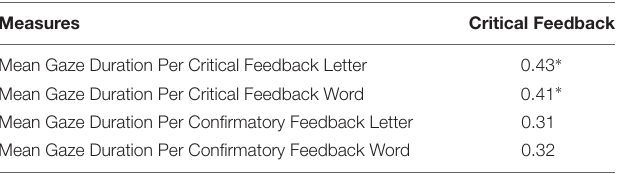
TABLE 3 | Bivariate correlations between the assigned critical feedback and the mean gaze durations per feedback valence by feedback letter and word. Measures